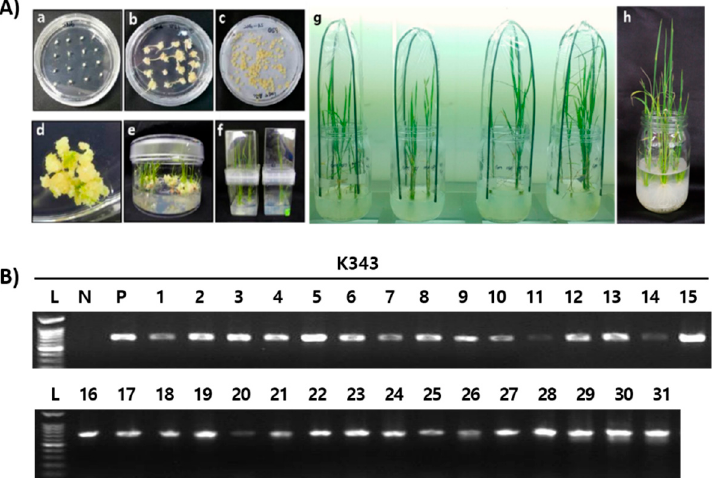
Figure 3. Development of transgenic rice plants with CRISPR/Cas9-OsPUB7 vector using Agrobacterium -mediated transformation. ( A ) Dongjin (WT) transformed with pPZP-3 ′ Pin Ⅱ -Bar vector containing the CRISPR/Cas9:sgRNA gene: ( a ) seeds plated on 2N6 media; ( b ) callus formation; ( c ) Agrobacterium co-culture in 2N6 AS media; ( d , e ) multi-shoot differentiation; ( f ) regenerated plants in rooting medium; ( g , h ) acclimation in tissue culture room and planted in soil. ( B ) Detection of sgRNA/Cas9-mediated DNA modifications using PCR analysis of bar and nos terminator regions. L, DNA ladder; N, negative control (sterile water); P, positive control (plasmid vector).